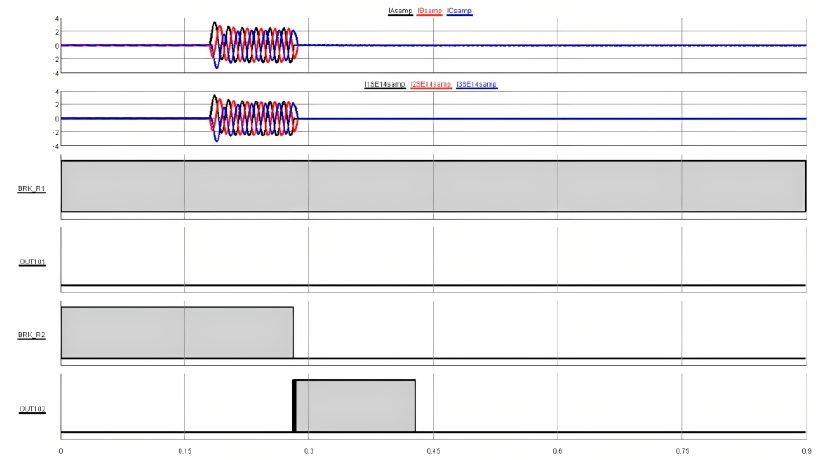
Figure 28. Waveforms when relay R2 operates to clear the fault.